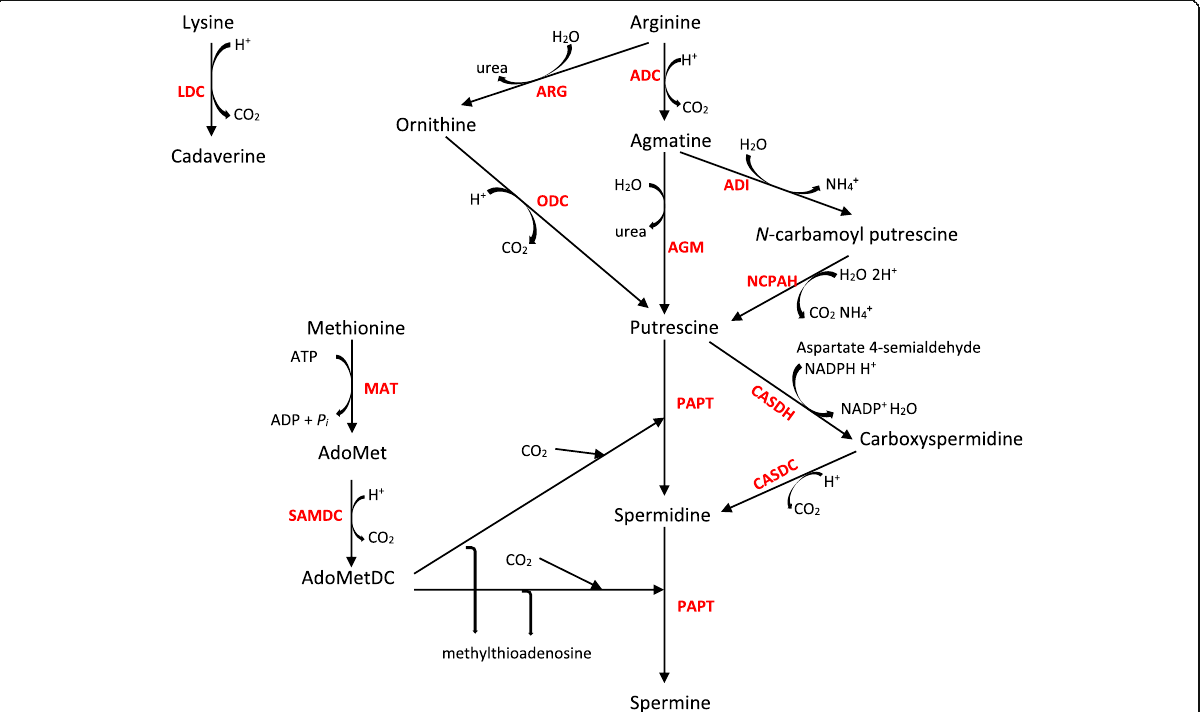
Fig. 2 Central common polyamine synthesis pathways in prokaryotes. ADC – arginine decarboxylase, ARG – arginase, ODC –